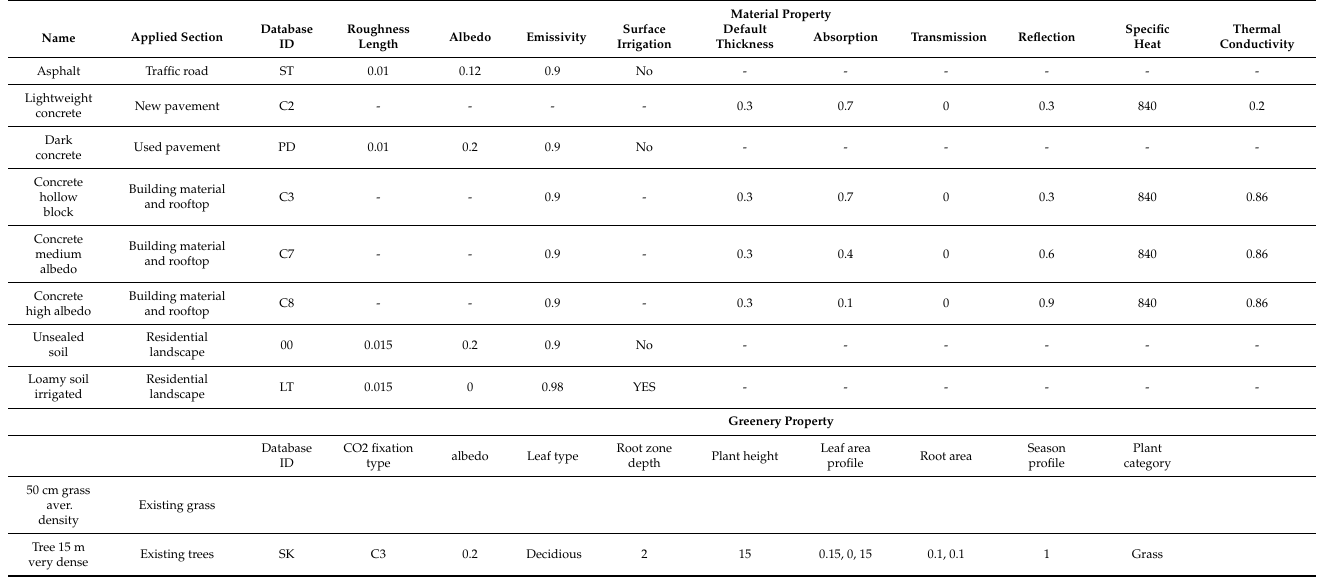
Table 2. Existing and proposed material specifications to run the